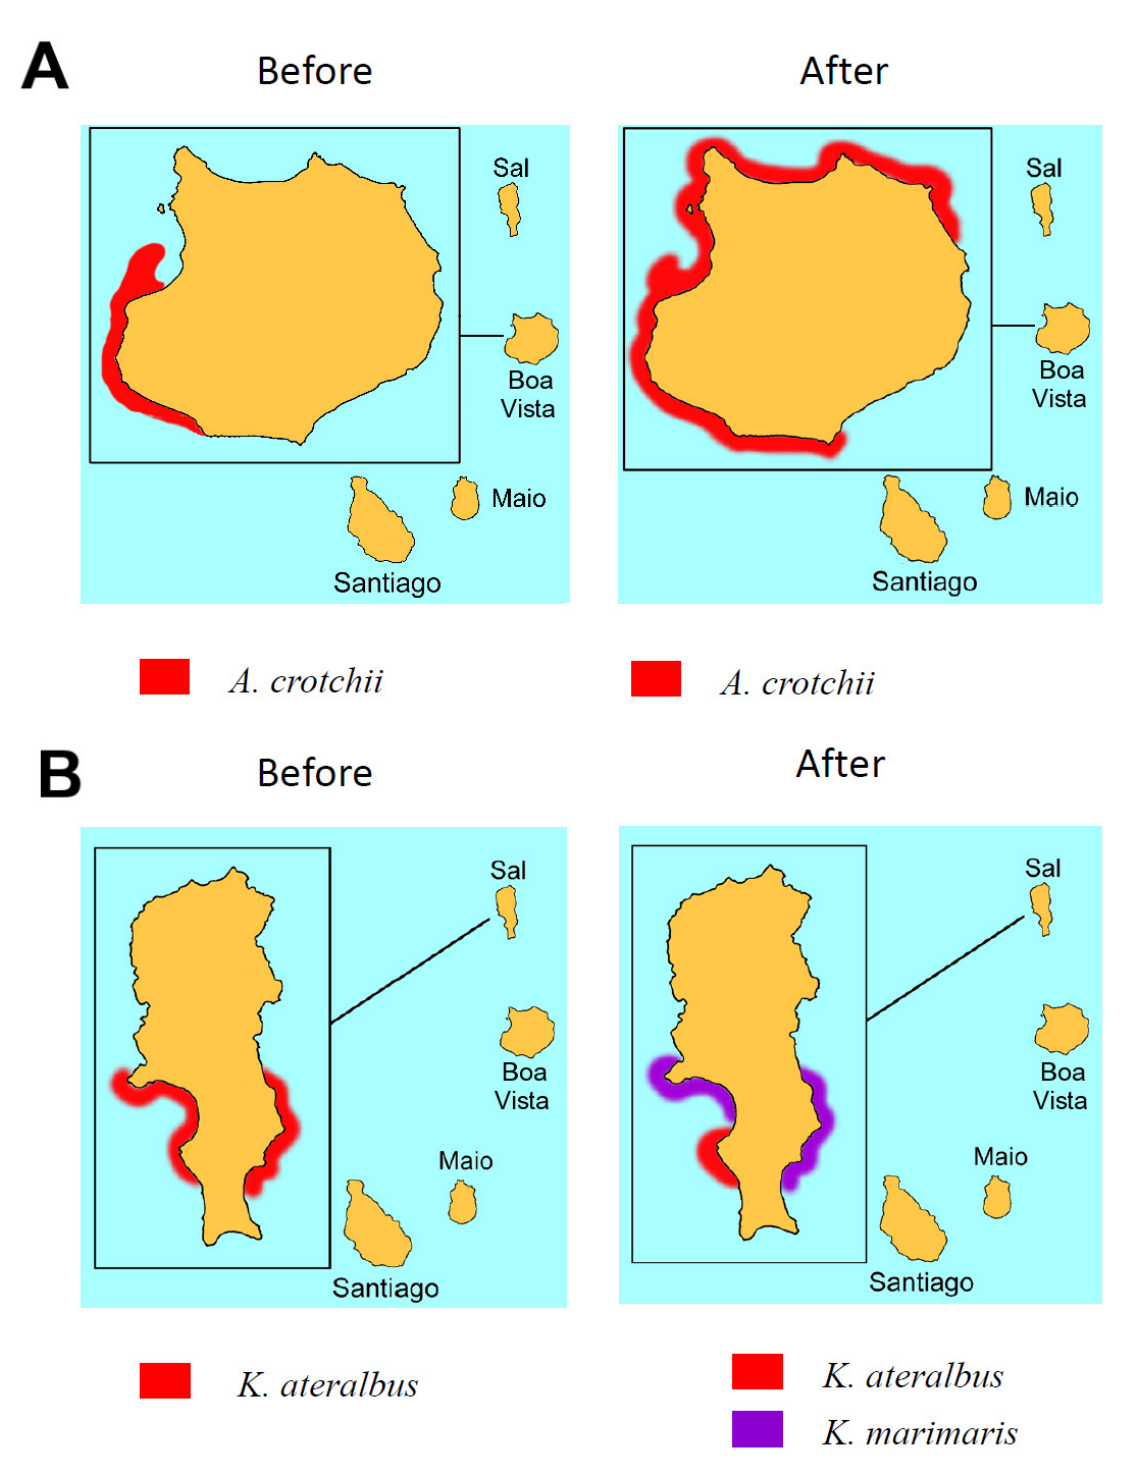
Fig. 13. Changes in distribution affecting Red List status due to the updated classification of cone snails from West Africa. A . The case of Africonus crotchii (Reeve, 1849) as an example of an increase in range distribution, and thus an estimated decrease on its risk status. B . The case of Kalloconus ateralbus (Kiener, 1850) as an example of a decrease in range distribution, and thus an estimated increase on its risk